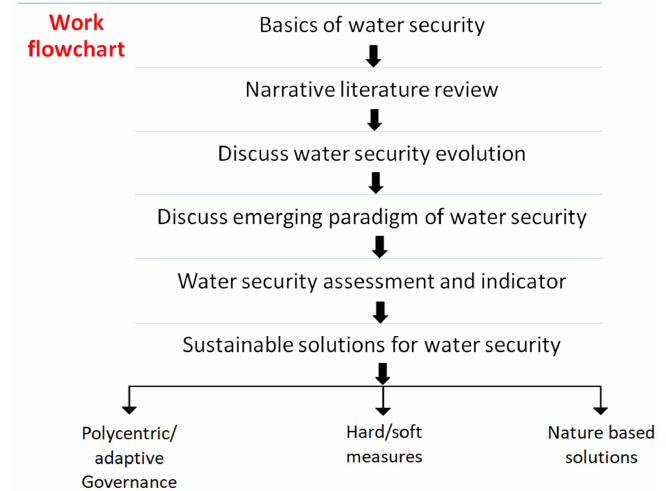
Figure 2. Flow chart explaining the work done in this study